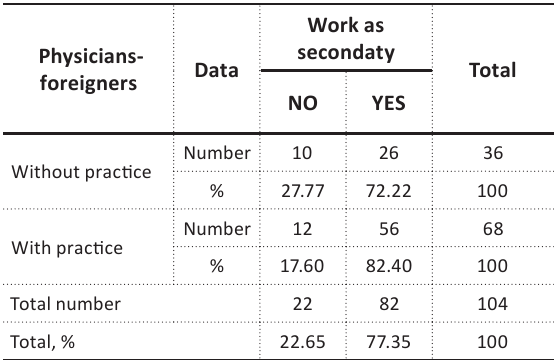
Table 4. Observed frequencies for H1